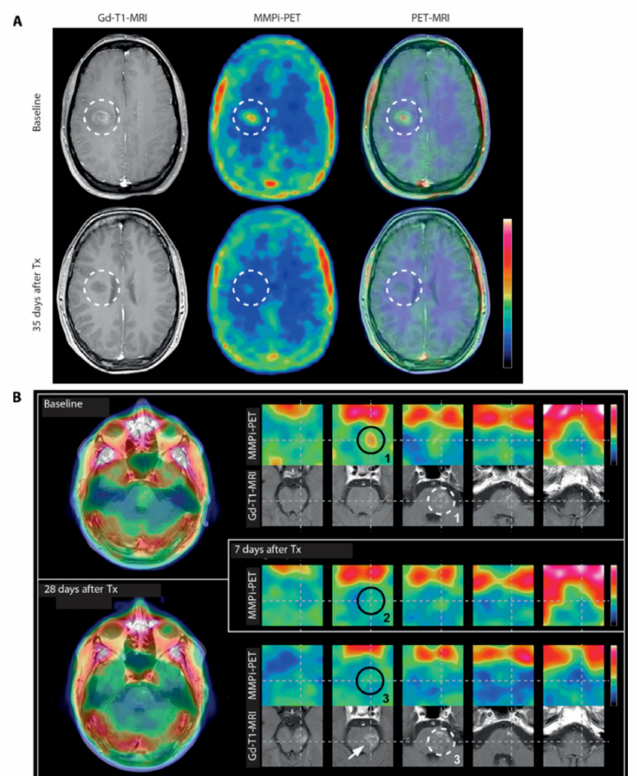
Figure 9. MMPI-PET [ 18 F] 15 and Gd-T1-MRI in MS patients before and after anti-inflammatory treatment. ( A ) [ 18 F] 15 and Gd-T1-MRI of patient #6 representing an acute attack of RRMS (EDSS 2.0) at baseline (top) and at 35 days after treatment (Tx) (methylprednisolone) (bottom); white dashed circles mark colocalization of the MMPI-PET signal and contrast enhancement in the MRI scan, which resolves by 35 days after treatment, correlating with a residual MMPI-PET signal. Left: Gd-T1-MRI. Middle: [ 18 F] 15 scan 30 to 60 min after injection co-registered to the Gd-T1-MRI scan. Right: An overlay of Gd-T1-MRI and (PET-MRI). ( B ) Patient #2 represents an acute attack of RRMS. Left: Single co-registered [ 18 F] 15 (30 to 60 min after injection) and Gd-T1-MRI slice at baseline (top) and 28 days after treatment (1 g of methylprednisolone, three times per day) (bottom). Right: Five consecutive PET (upper row) and corresponding MRI (bottom row) slices at baseline (top panel), 7 days after therapy (middle panel, PET only), and 28 days after therapy (bottom panel). Note the intense contrast enhancement in Gd-T1-MRI (maximum, white dashed circle #1) with spatially adjacent but not identical MP activity (black circle #1) at baseline. Reduced MMPI-PET signal at 7 days after therapy (black circle #2), and by 28 days after therapy, the MMPI-PET signal remains low (black circle #3), but the Gd-T1-MRI signal now colocalizes to the original MMP active area from the baseline scan. Reprinted with permission from [103] Copyright © 2016, American Association for the Advancement of